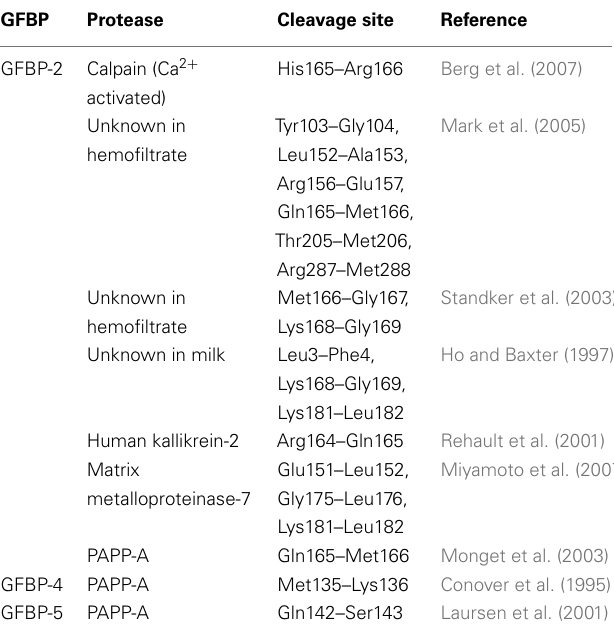
Table 2 | IGFBP-2 proteolytic cleavage sites and PAPP-A cleavage sites on IGFBPs-4, and -5 as identified by mass spectrometry and/or N-terminal